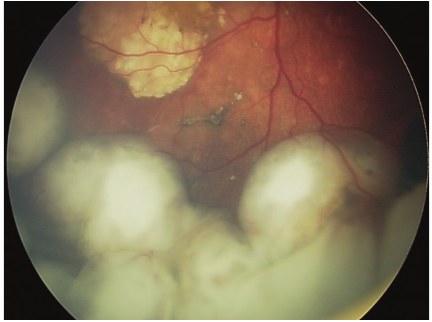
Figure 1: Fundoscopic exam revealing an intraocular retinoblas- toma before treatment with intra-arterial